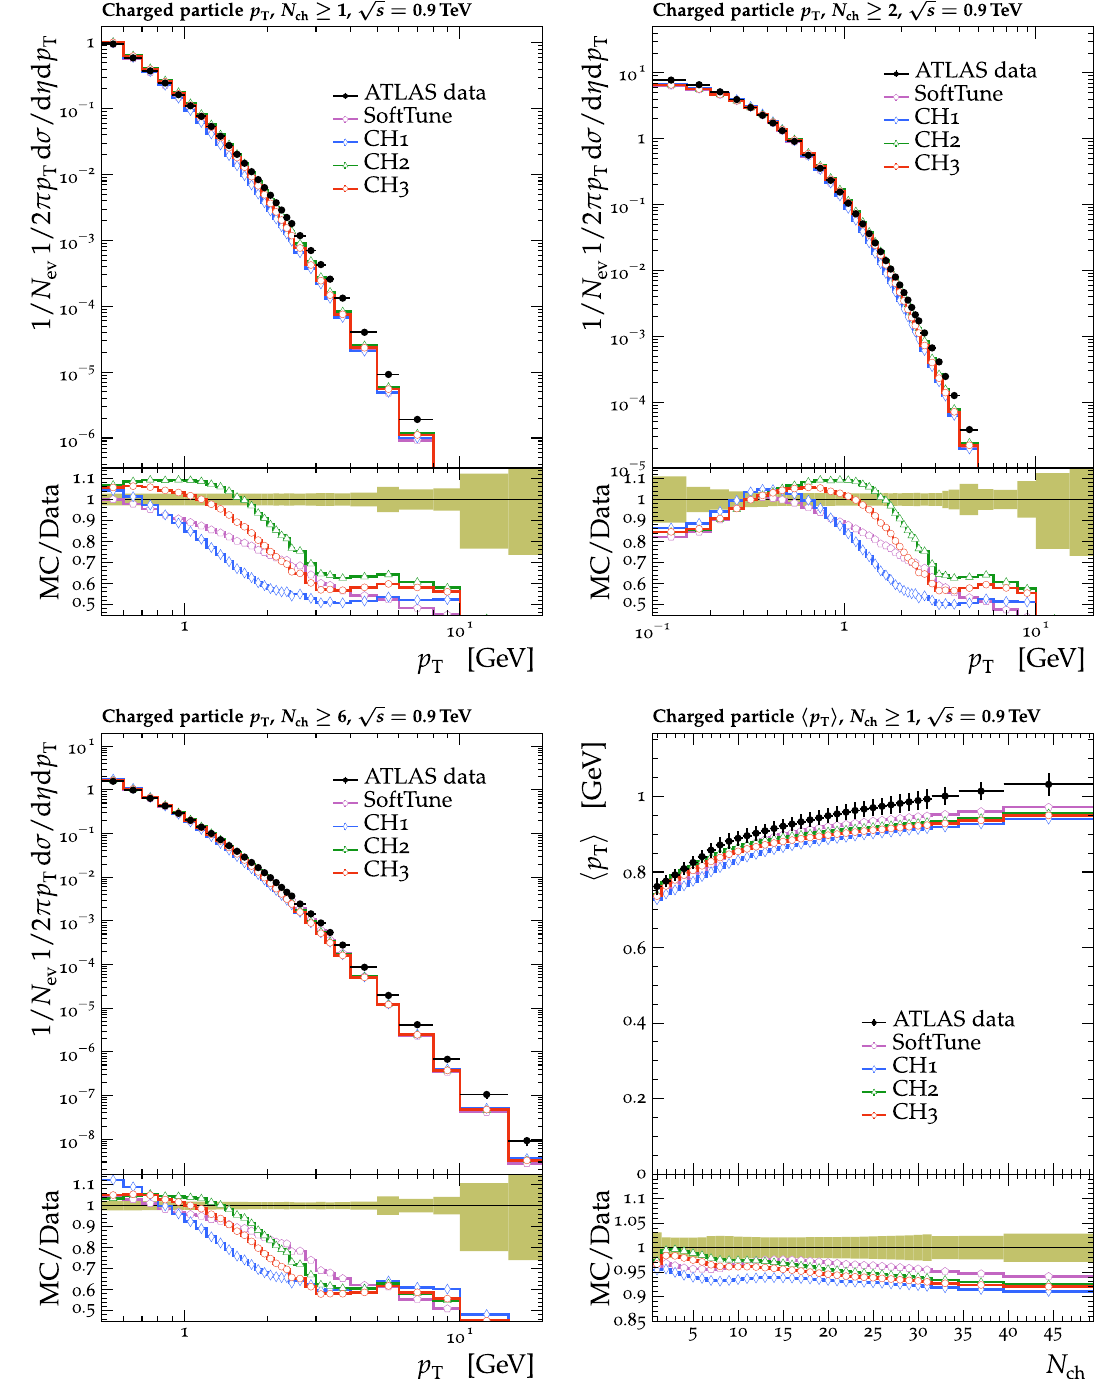
Fig. 22 Normalized plots [17] for the charged-particle p T for N ch ≥ 1 (upper left), N ch ≥ 2 (upper right), and N ch ≥ 6 (lower left). The mean charged-particle p T as a function of the charged-particle multiplicity is also shown (lower right). ATLAS MB data are compared with the pre-